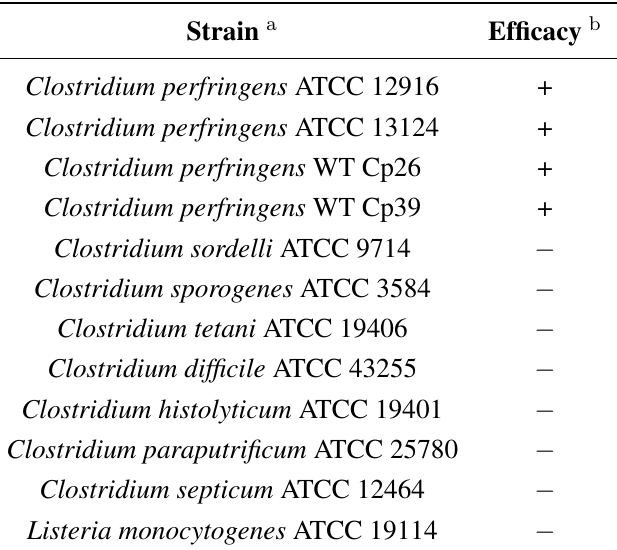
Table 1. PlyGVE2CpCWB effectiveness against various